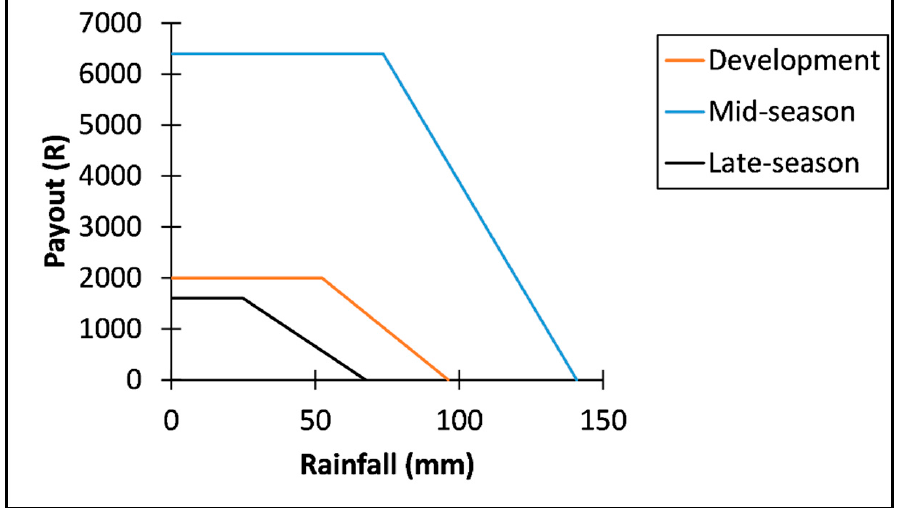
Figure 4. Development stage (trigger = 96.27 mm, exit = 52.40 mm), mid-season (trigger = 140.87 mm, exit = 73.55 mm), late-season (trigger = 67.52 mm, exit = 24.94 mm).